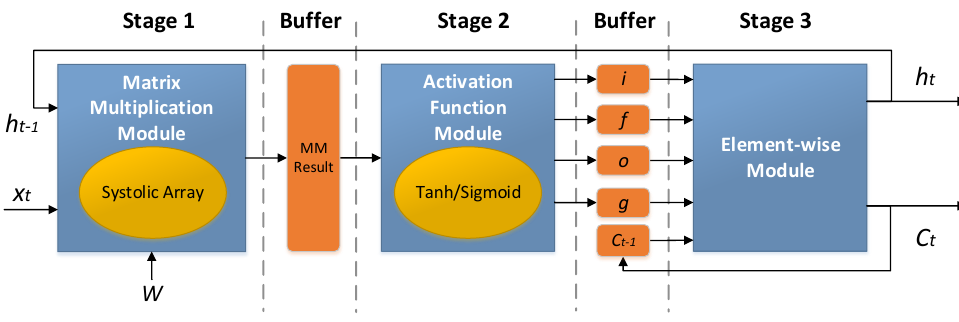
Figure 2. The system structure of the proposed LSTM